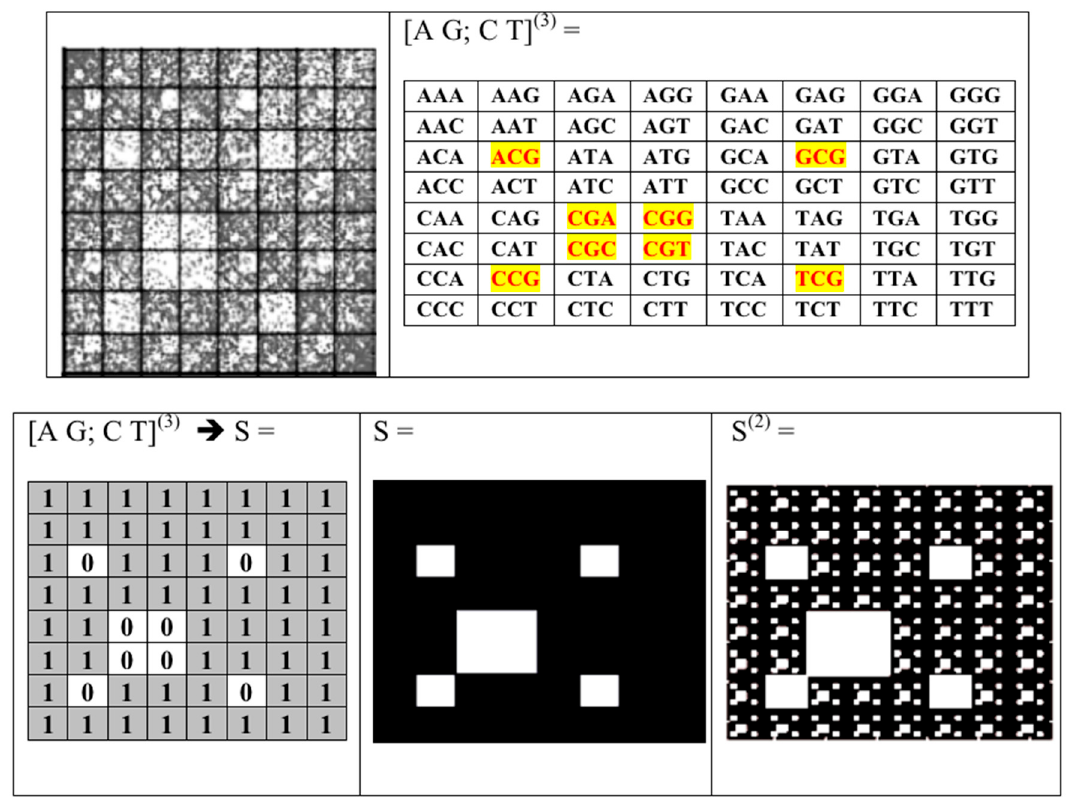
Figure 9. Illustration of relations among Kronecker multiplication, fractal lattices and fractal-like patterns of long nucleotide sequences (explanations in text).